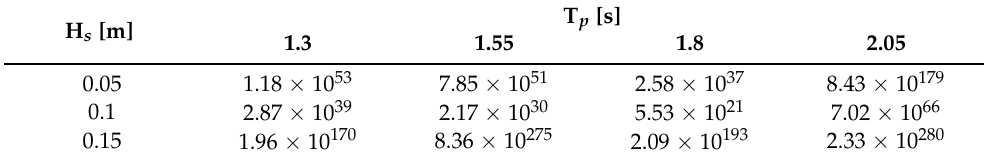
Table A1. Kruskal–Wallis test p -values for all facilities. Values greater than 0.05 marked in bold.